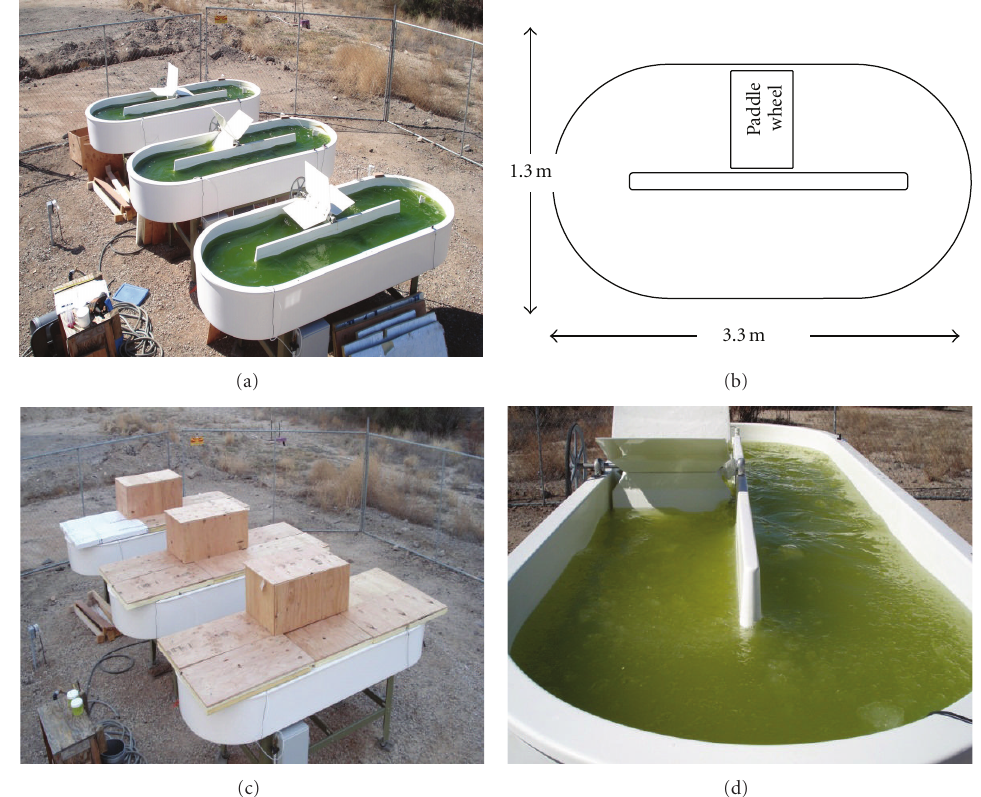
Figure 2: (a) Conventional raceways 26 days after inoculation on 2/21/2011. (b) Raceway schematic and dimensions. (c) Night-time operation. (d) Ice slurry after record lows on 2/3/11.